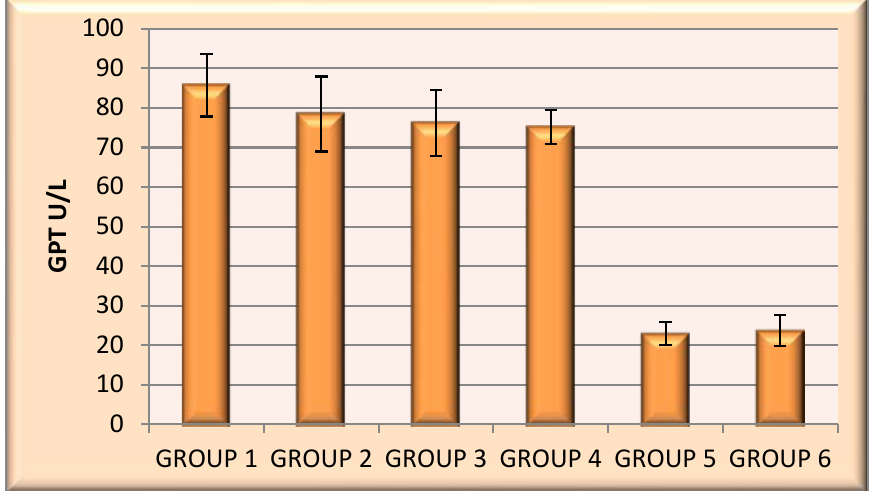
Figure 9. Mean GPT values for the encapsulated samples from the six groups of animals.